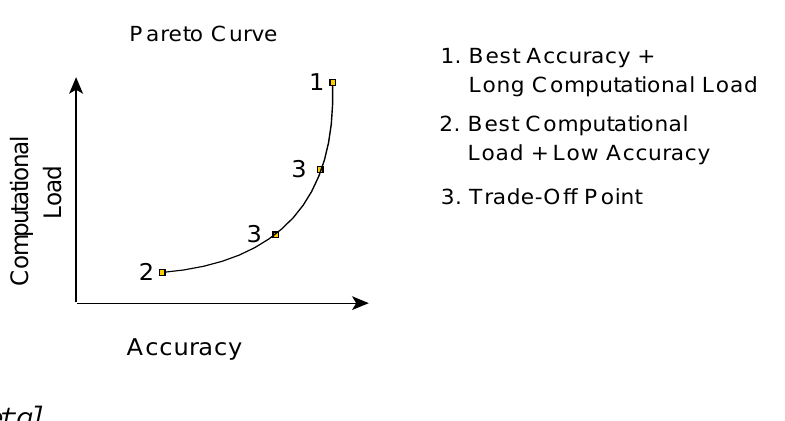
Figure 21. Explanation of the Pareto